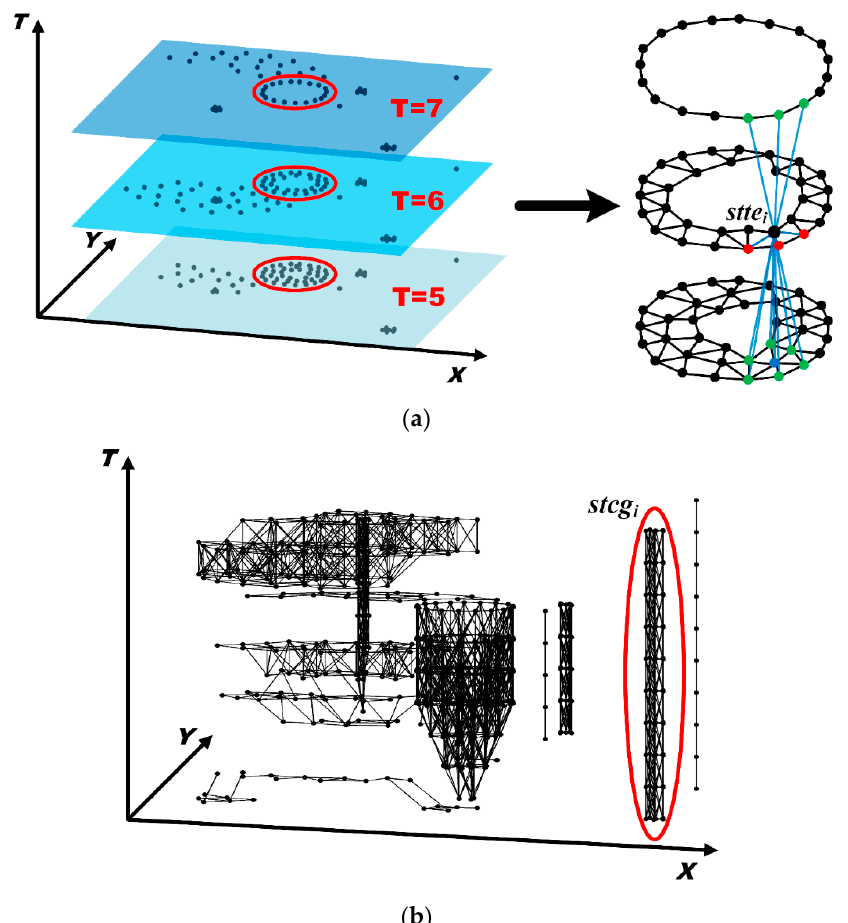
Figure 7. The construction of spatial proximity relationships. ( a ) spatio-temporal Twitter events from T = 5 to T = 7; ( b ) spatio-temporal connecting graphs.